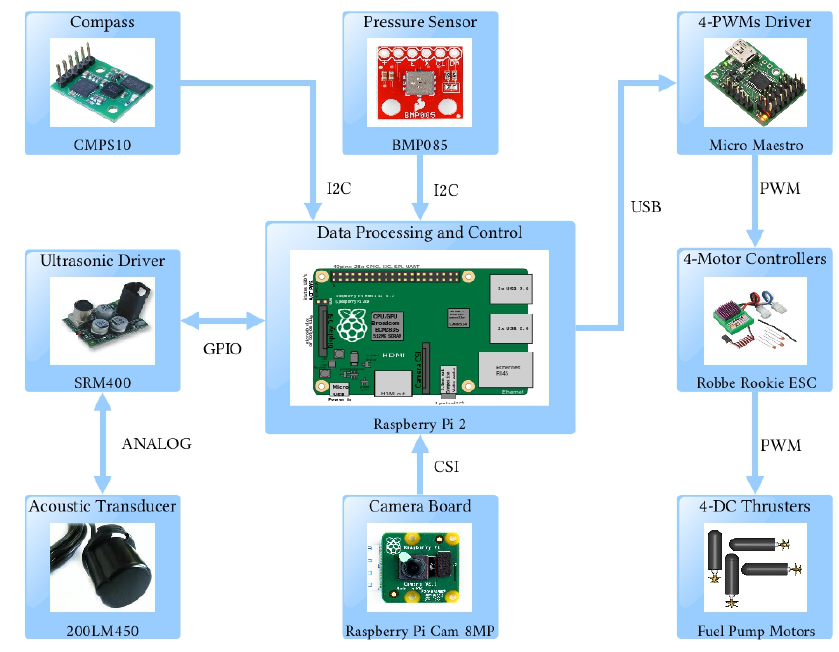
Figure 2. Electronic architecture of the embedded